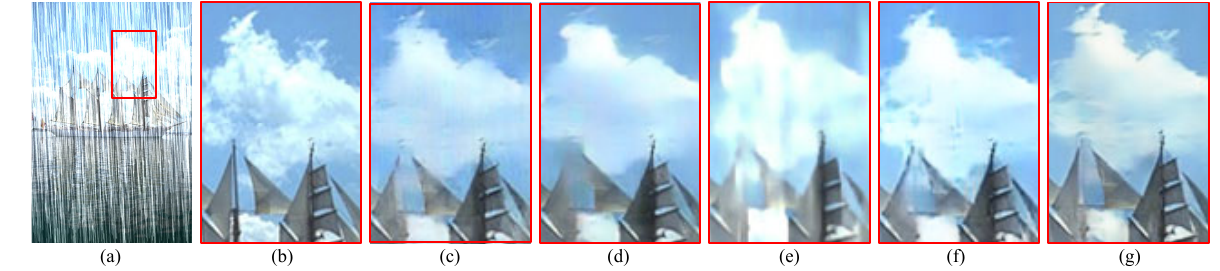
Figure 2. Comparisons of deraining results on ( a ) Rainy image. ( b ) Ground-truth. ( c , d ) The results from sequential frameworks (RESCAN [12], MPRNet [16]). ( e , f ) The results from multi-stream frameworks (MSPFN [13], PCNet [17]). ( g ) Deraining result from our